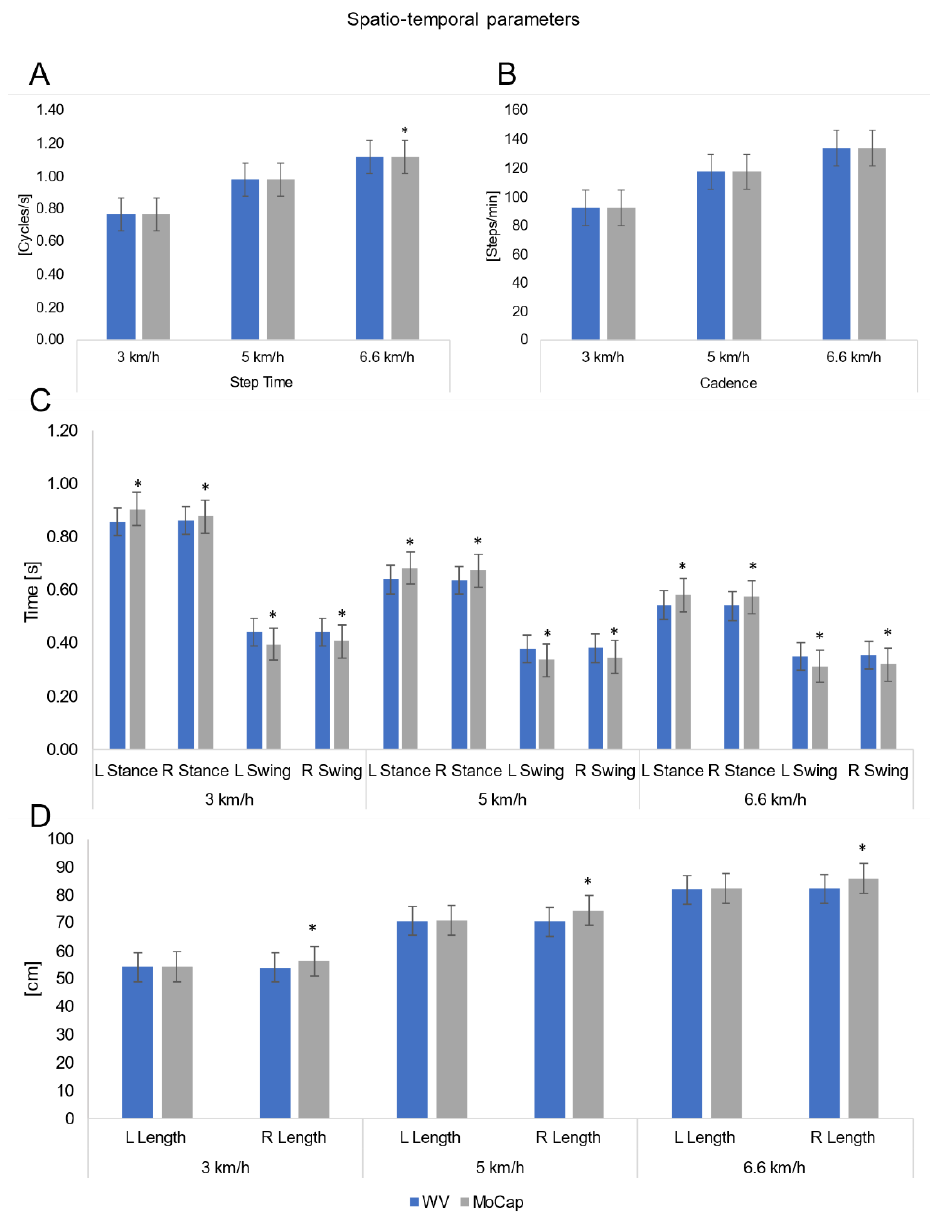
Figure 4. Mean and Standard Deviations (SD) of spatiotemporal parameters. L = left; R= Right. ( A ) Non-significant differences for step time except at 6.6 km/h ( p < 0.046). ( B ) Cadence recorded by the two systems did not show significant differences. ( C ) WalkerView TM (WV) underestimated stance time and overestimated swing time at all walking speeds ( p < 0.05). ( D ) WV underestimated R steps length at all walking speeds ( p < 0.05); non-significant differences for L steps length. Asterisks (*) indicate statistically significant differences ( p < 0.05-Wilcoxon signed-rank test).